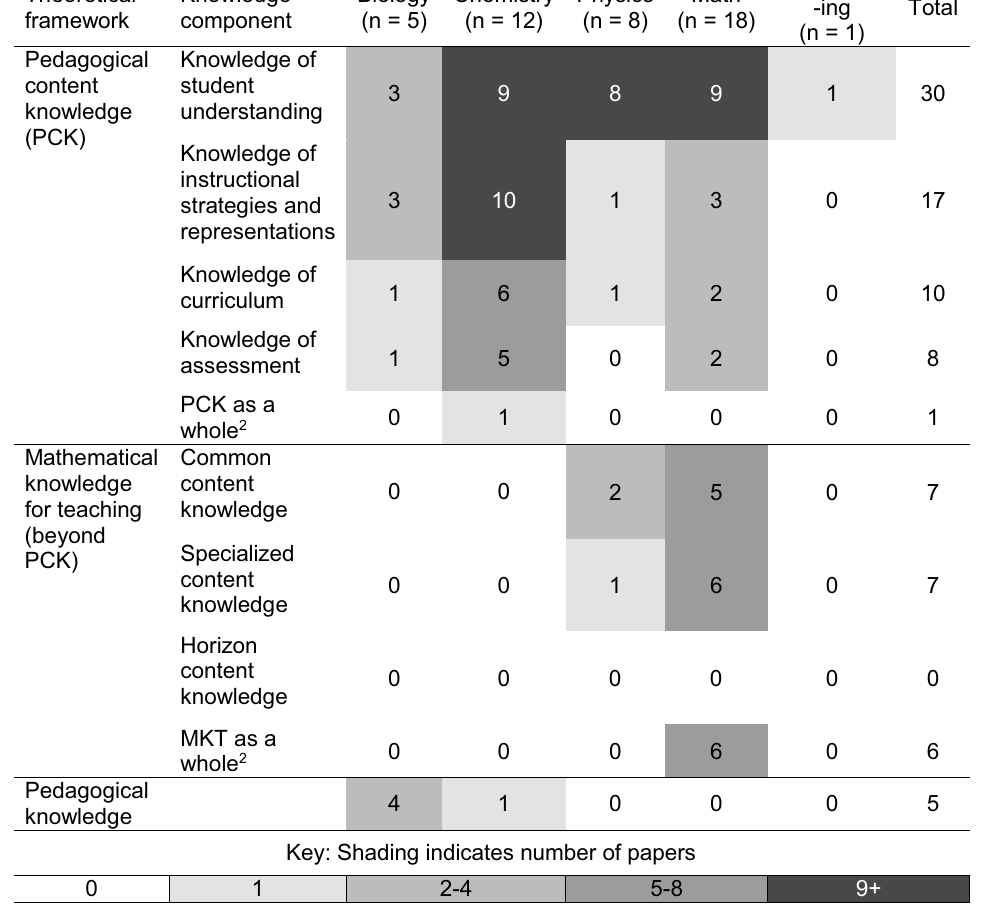
45) by discipline and knowledge component(s) studied =